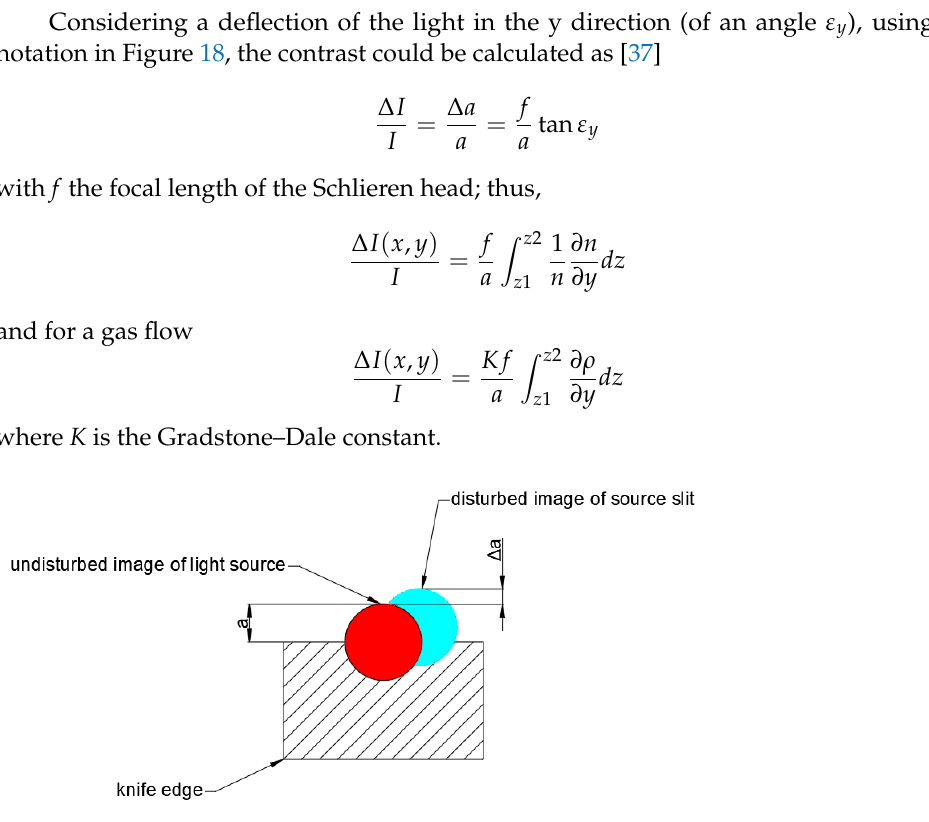
Figure 18. Knife edge working principle.